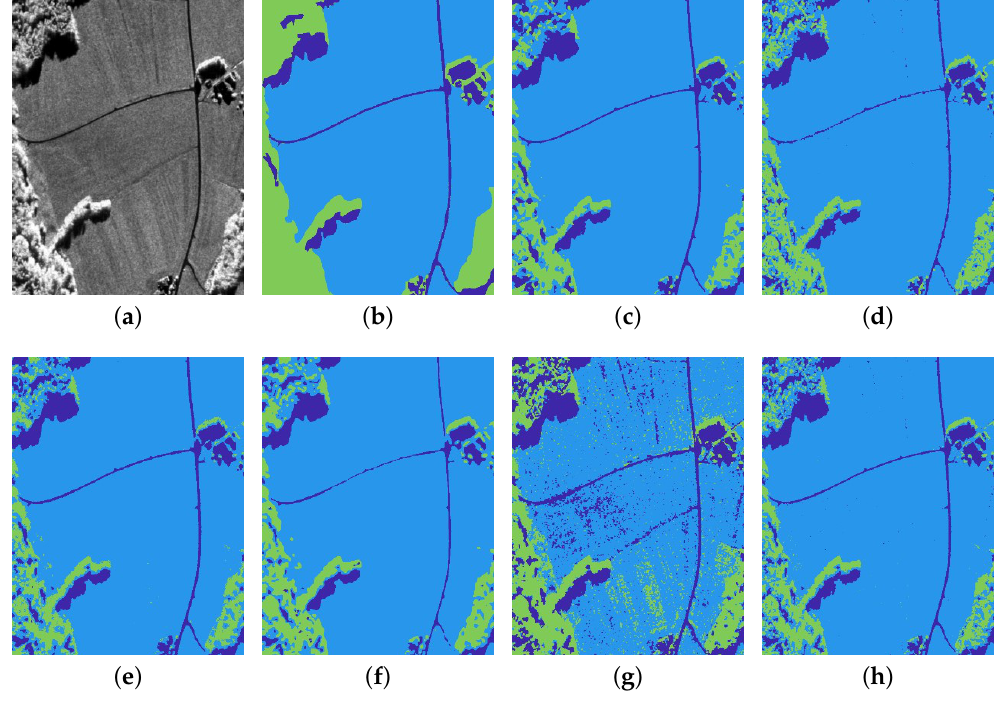
Figure 18. Segmentation results: ( a ) experimental image, ( b ) ground truth, ( c )